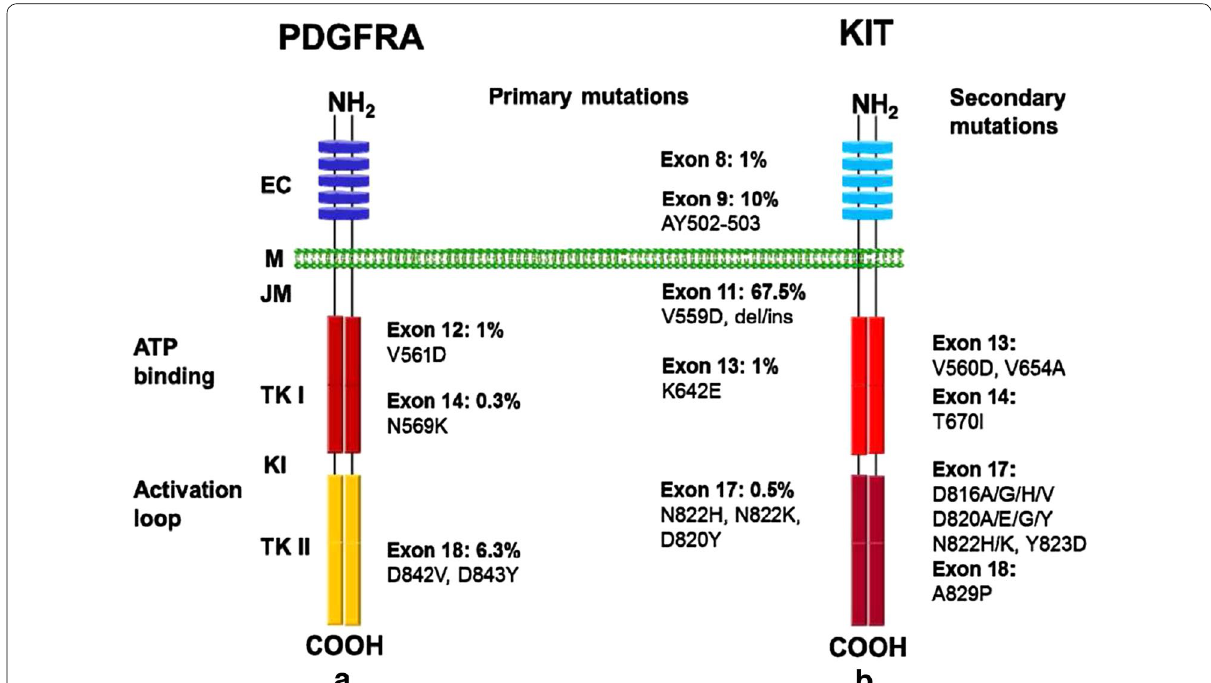
Fig. 2 Schematic structures of PDGFRA and KIT . a Primary oncogenic mutation in PDGFRA . b Distribution of primary and secondary mutations in KIT . EC extracellular domain, M membrane, JM juxtamembrane domain, TK I tyrosine kinase domain I, KI kinase insert, TK II tyrosine kinase domain